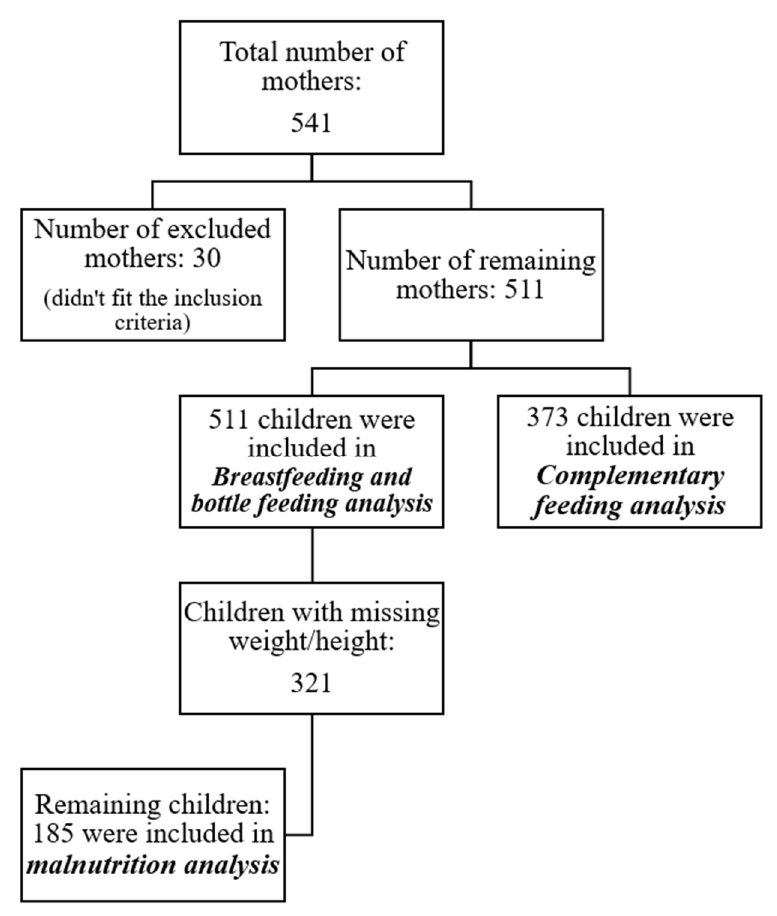
Figure 1. Description of the sampling details.